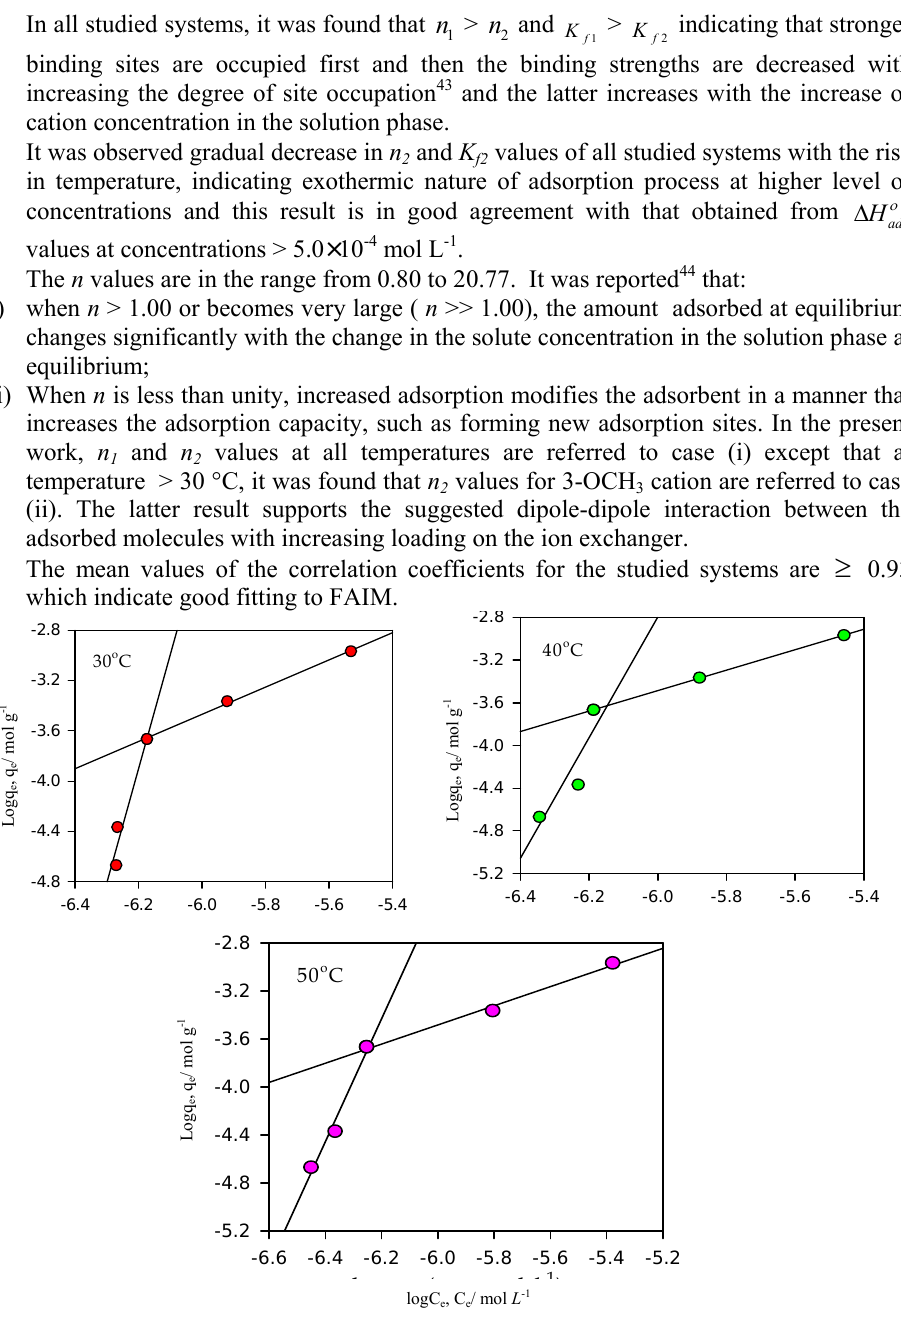
organic cations onto Dowex 50WEX/H + at 3